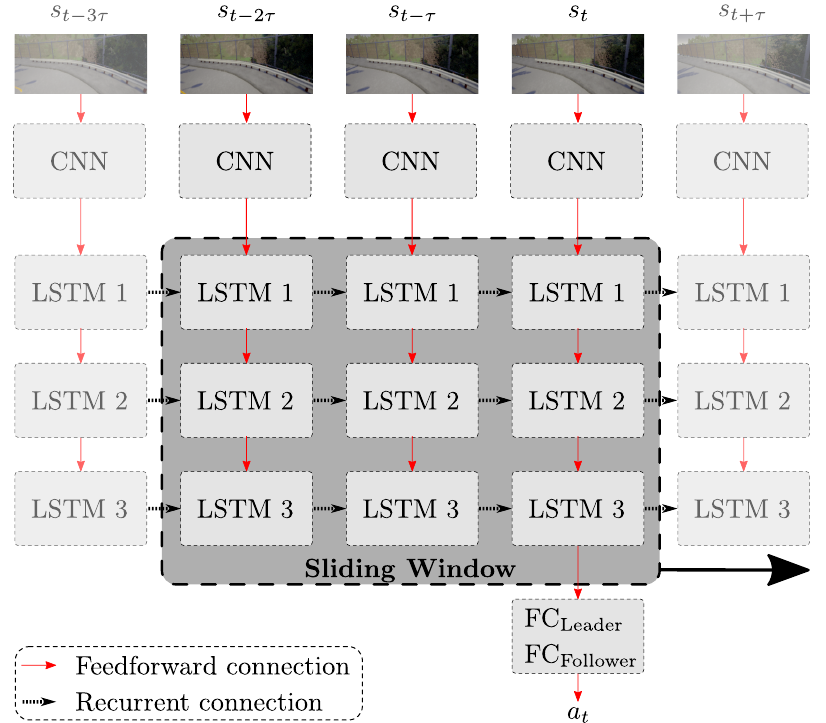
Figure 3. Model B: multi-task network with LSTM extension. Three LSTM layers follow the feature extractor output. The sliding window method includes the last (cid:96) images with a time step of τ between the